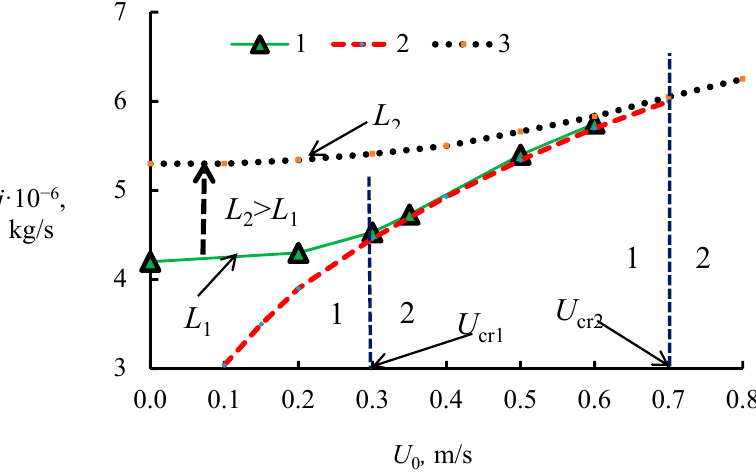
Figure 5. The dissociation rate j of methane hydrate depending on the velocity of the incoming air flow U 0 : 1—experiment; 2—calculation by (2); U cr1 = 0.3 m/s; U cr2 = 0.7 m/s [29]; 3—Shift curve2 to the top; and L —the characteristic lengths of the working area.